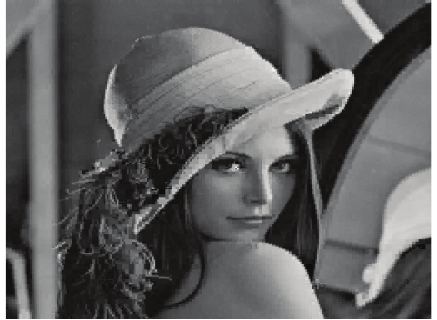
Figure 11: IFBP, PSNR = 29.9